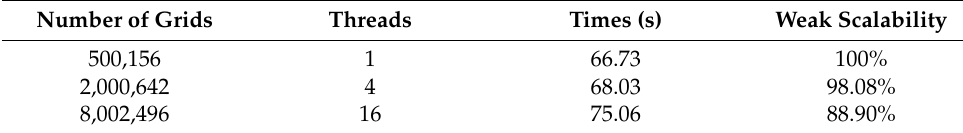
Table 4. The weak scalability results of 2D elliptical cylinder flow.